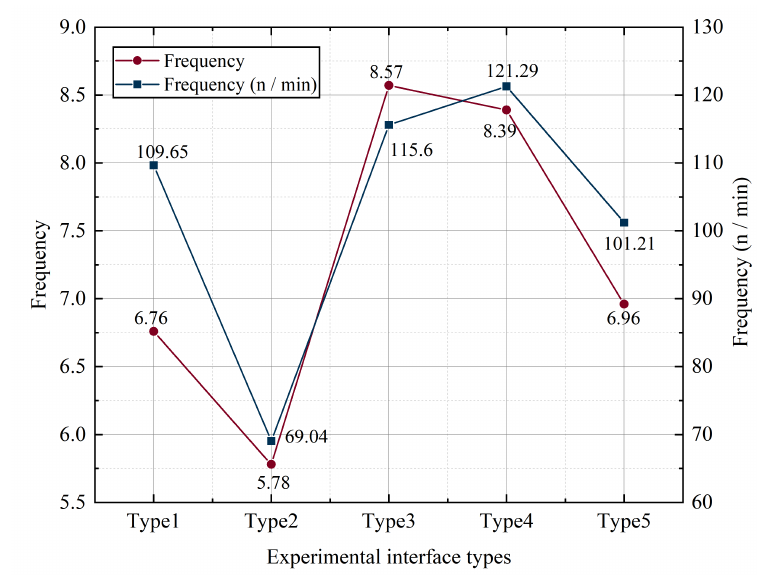
Figure 9. Mean value of eye movement data for different button sizes.